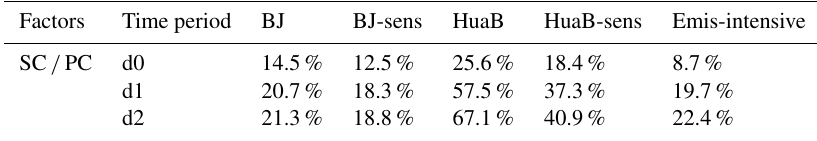
Table 3. Emission source contribution to the average PM 2 . 5 concentration over Beijing on 21 November. Factors